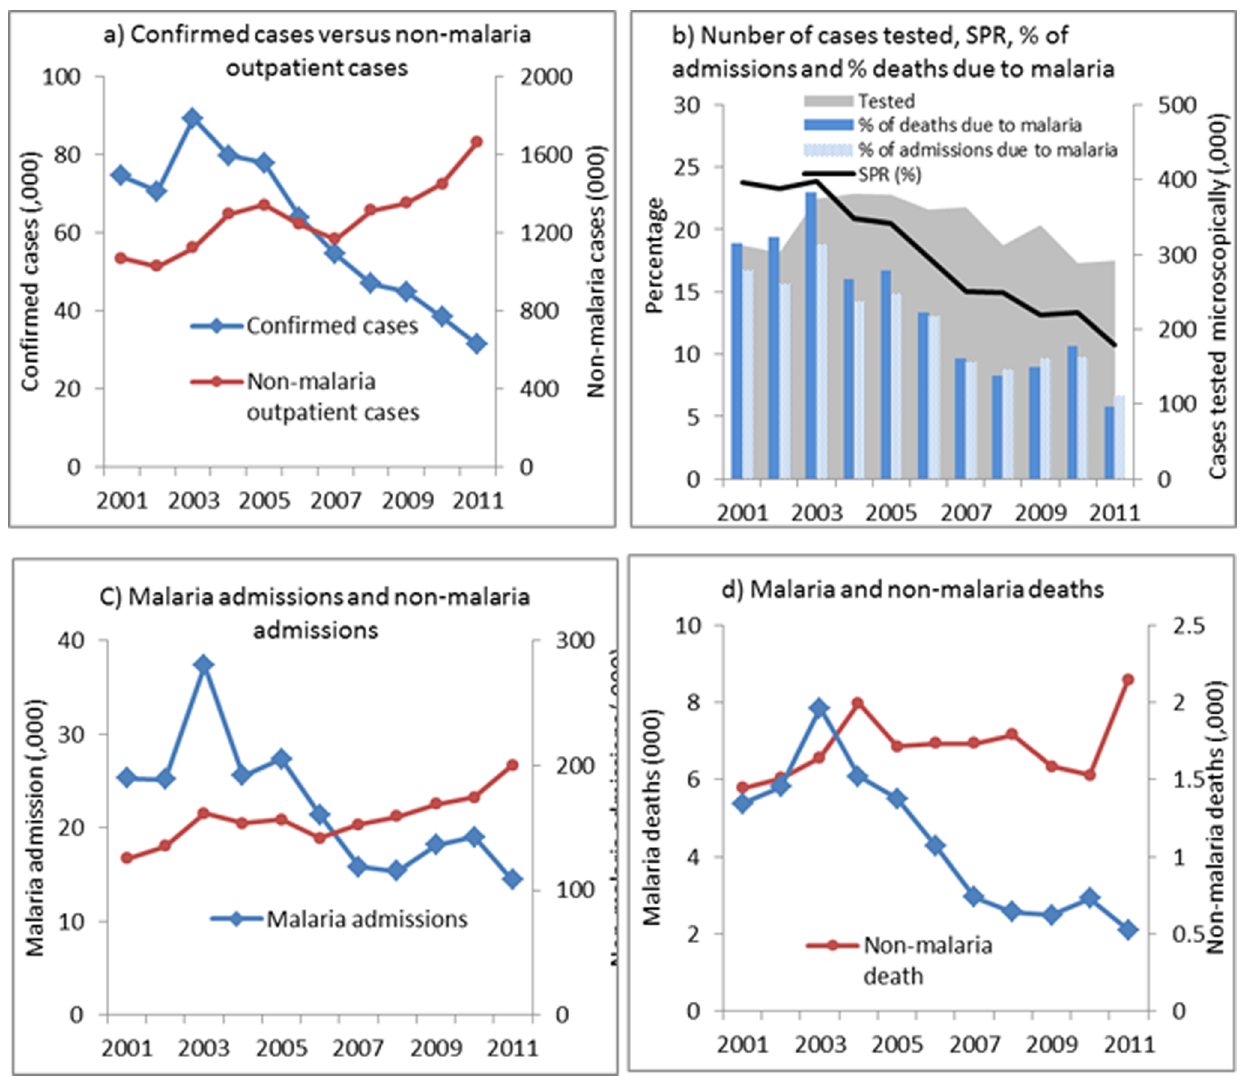
Figure 4. Trends of confirmed malaria cases and non-malaria outpatient visits (a); slide positivity rate and number of microscopic slides examined (b); malaria admissions and non-malaria admissions (c); malaria deaths and non-malaria deaths in all ages (d) in 41 hospitals, Ethiopia 2001–2011.